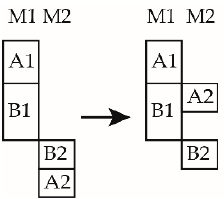
Figure 1. Demonstration of compact scheduling.